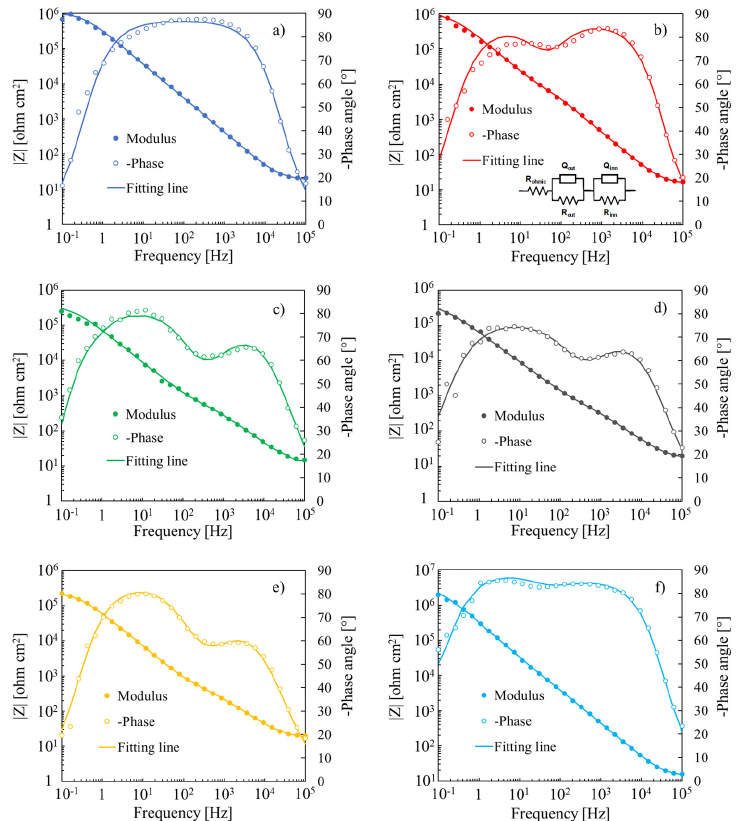
Figure 5. Bode representation of EIS spectra relating to all the investigated 50 V anodic oxides grown on ( a ) Ta, ( b ) Ta-19at% Nb, ( c ) Ta-39at% Nb, ( d ) Ta-66at% Nb, ( e ) Ta-85at% Nb and ( f ) Nb, recorded at U E = 8 V vs. Ag/AgCl in 0.25 M Na 2 HPO 4 . Inset: EEC employed to model the metal/anodic oxide/electrolyte interfaces.